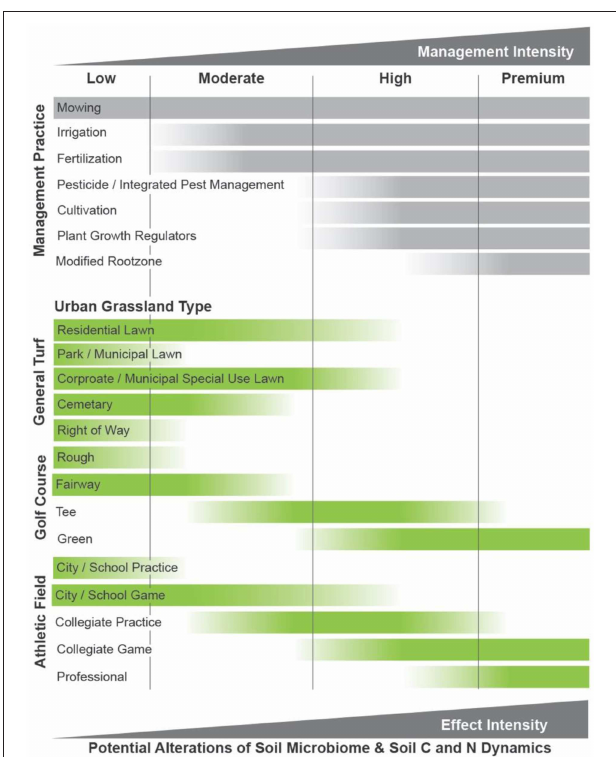
FIGURE 2 | The wide-range of maintenance practices that are used to manage urban grasslands can be grouped into increasing levels of management intensity. They range from low-to-high for most urban grassland types, except for some golf course and athletic fields that require intensive management and inputs. This framework can be used to gauge the potential for alterations to the soil microbiome or soil biogeochemical cycling of different urban grassland types on the basis of management intensity, though more research is